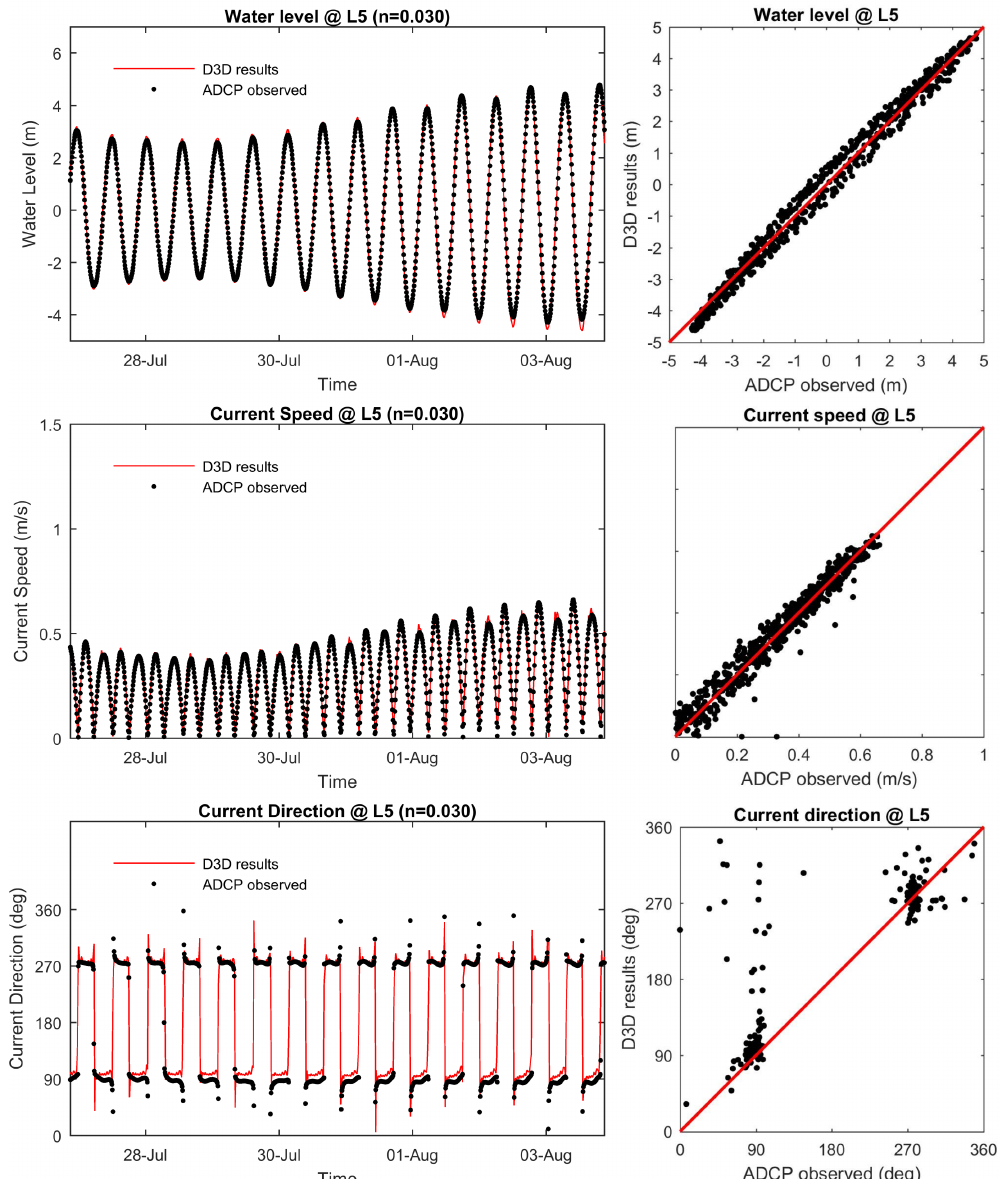
Figure 7. Validation results at location L5, showing time series of water levels and flow velocity ( left ) and scatter plots comparing the observations and simulation results ( right